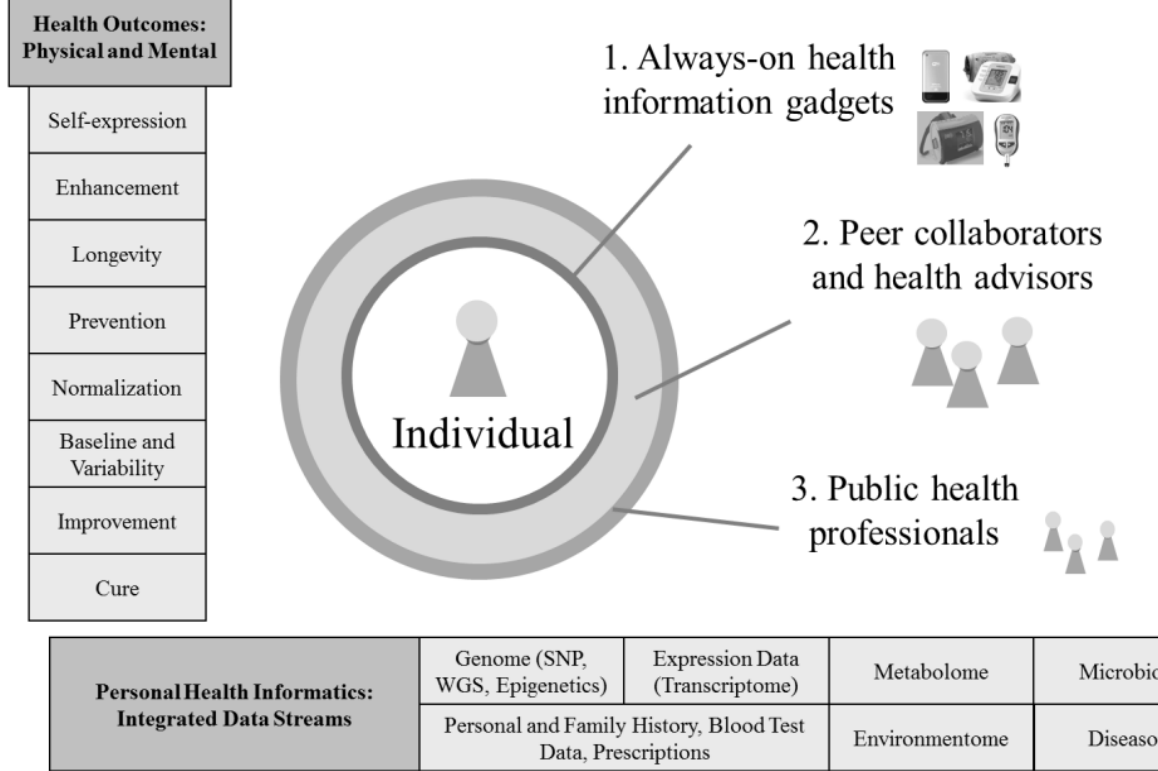
Figure 1. Health 2050: An expanded concept of health and health care. SNP: single nucleotide polymorphism, WGS: whole human genome